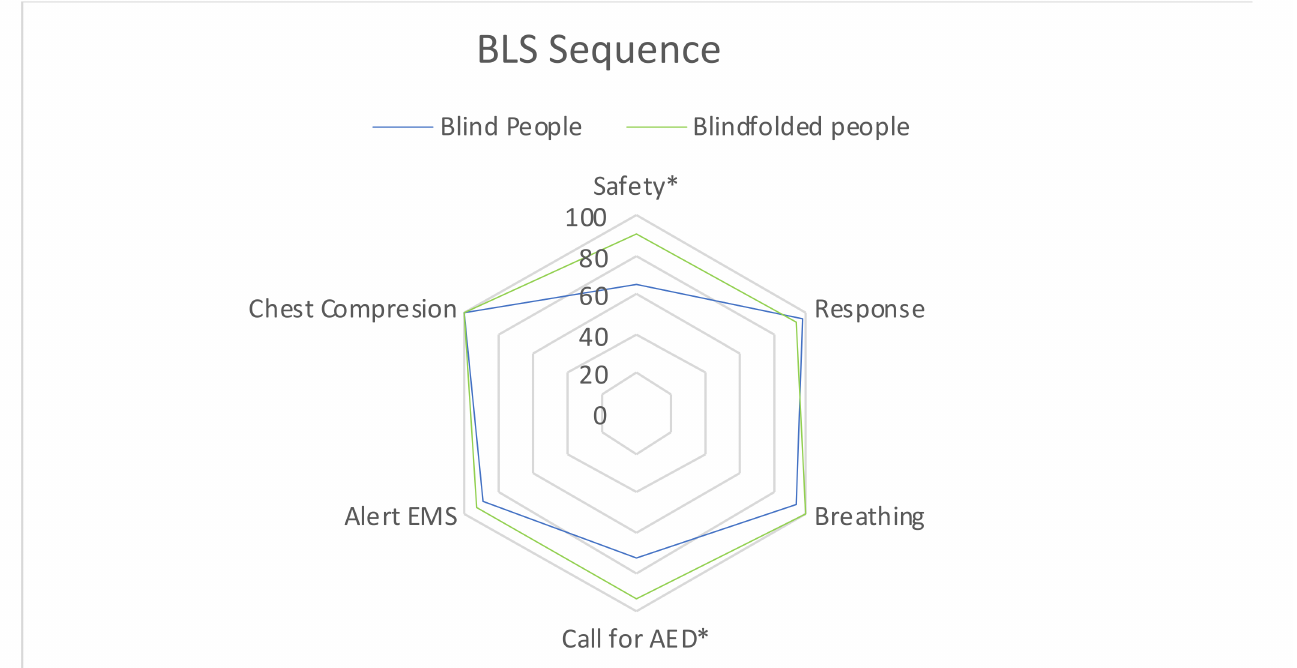
Figure 1. Comparison of BLS sequence performance between groups. * p <